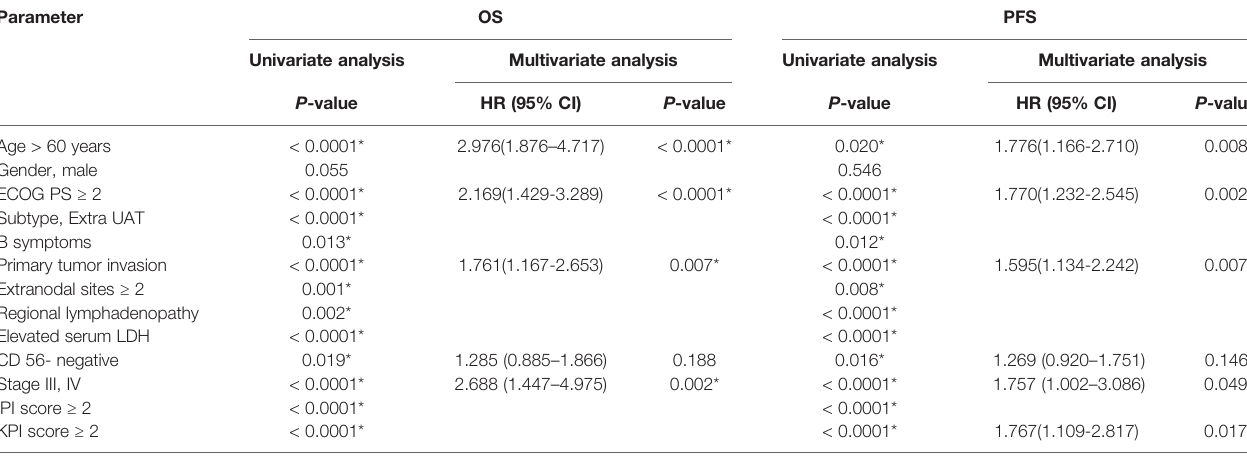
TABLE 3 | Results of univariate and multivariate analyses of prognostic factors for OS and PFS in all patients.